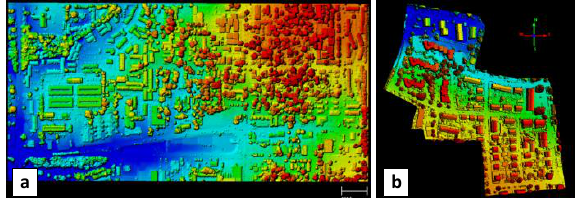
Figure 3. DSMs of (a) Bloomington with 5ft/1.5m and (b) Vaihingen with 0.3m GSD. Blue-to-red color ramp represents low-to-high elevation values relative for each